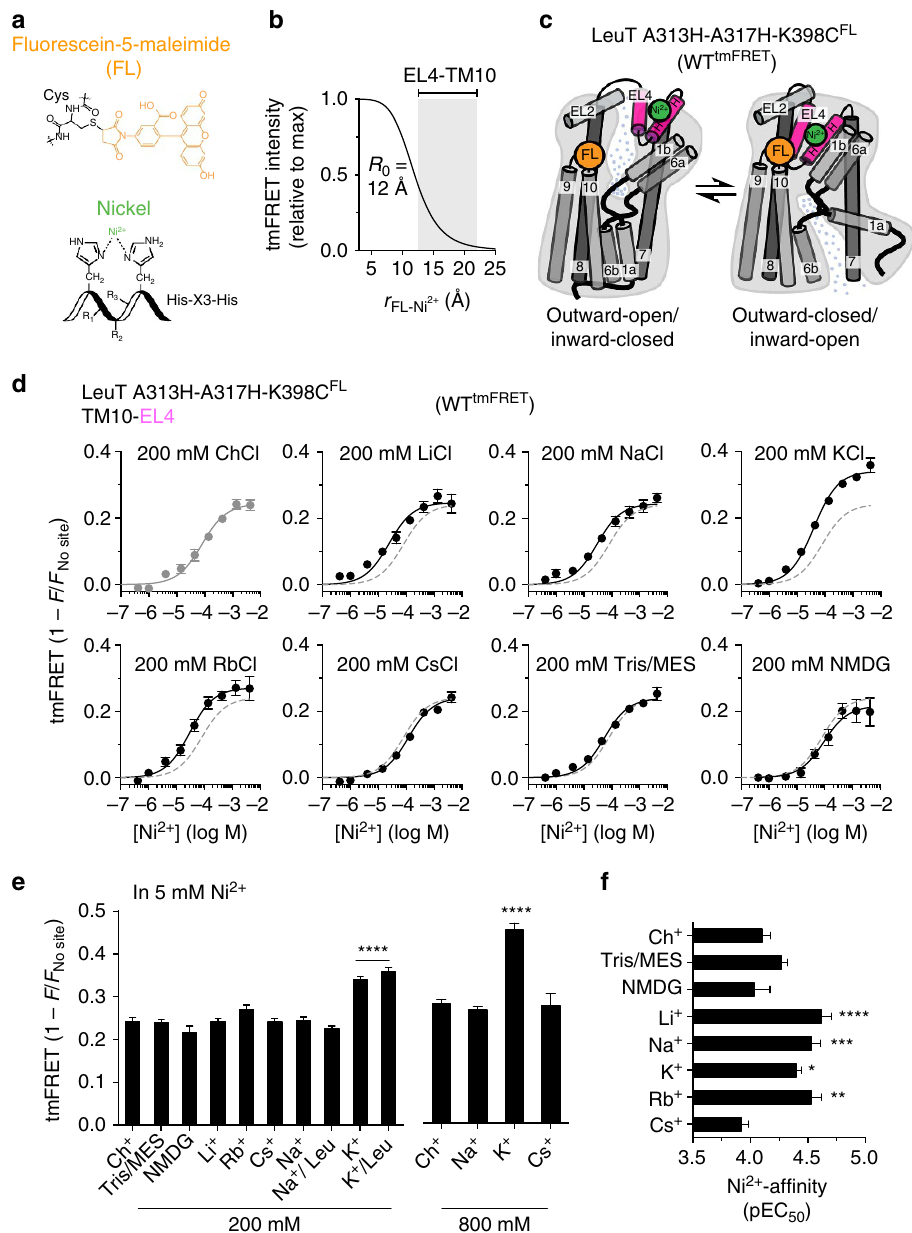
Figure 2 | K þ induces a different tmFRETstate than other tested cations. ( a ) Chemical structures of fluorescein-5-maleimide (orange) conjugated to a cysteine, and a nickel ion (green) coordinated by the imidazole moieties of two histidines inserted in an alpha-helical motif one helix-turn apart (His- X 3 -His). ( b ) Expected dynamic range (grey area) of the EL4:TM10 tmFRET pair-based LeuT-crystal structures and the FL-Ni 2 þ Fo¨rster distance ( R 0 ¼ 12Å). ( c ) Cartoon of LeuTwith EL4:TM10 tmFRETpair shown in outward open and outward closed states depicting the principle behind changes in tmFRETas a result of conformational changes. The tmFRETpair reports distance-dependent quenching of fluorescence from FL conjugated to an inserted cysteine at the top of TM10 (orange sphere, K398C) by Ni 2 þ coordinated by a His- X 3 -His motif in EL4 (green sphere, A313H-A317H). ( d – f ) Detecting distance–dependent fluorescence quenching as a function of Ni 2 þ in LeuTwith EL4:TM10 tmFRETpair (LeuT A313H-A317H-K398C FL ; see Supplementary Fig. 1 for tmFRET proof-of-principle applied to LeuT). ( d ) tmFRET intensity as a function of [Ni 2 þ ] performed in 200mM of the indicated salts yielded saturable tmFRETresponse. Dotted line represents tmFRET in ChCl (grey) for comparison. ( e ) Maximal tmFRETvalues from the experiments performed in d compared with experiments performed in 800mM of the indicated salts. K þ significantly and dose-dependently increases tmFRET values, consistent with a decrease in the TM10-EL4 mean distance. The addition of leucine (100 m M) to Na þ or K þ does not change tmFRET response relative to the ion alone. ( f ) Ni 2 þ affinities (pEC 50 ) obtained from experiments shown in d , indicate that Na þ , Li þ , K þ and Rb þ (compared with Ch þ ) induce a change in the EL4 secondary structure that stabilizes a configuration with increased Ni 2 þ affinity. Data points are means ± s.e.m., n ¼ 3–6. * P o 0.05; ** P o 0.01; *** P o 0.0005; **** P o 0.0001; denote significance level from a one-way analysis of variance with post hoc Bonferroni’s multiple comparison test relative to the Ch þ condition in the same experimental